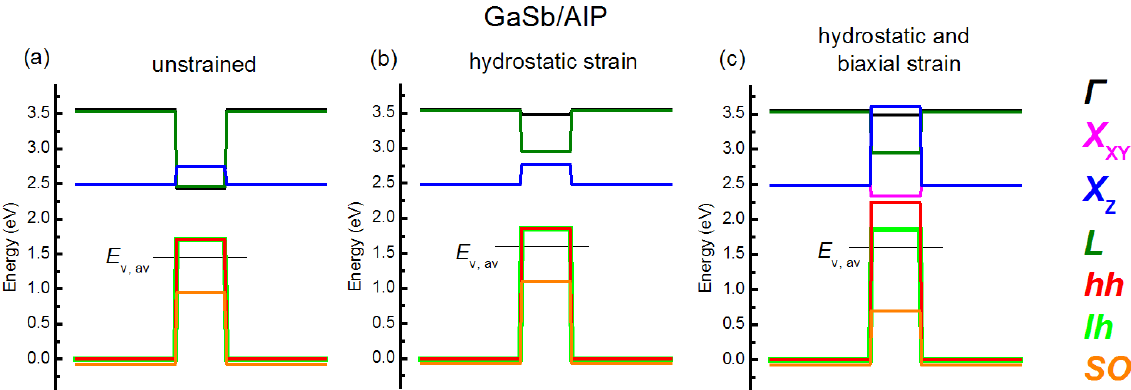
Figure 6. Band alignment for the thin GaSb layer coherently strained to the AlP matrix oriented along the (100) plane. The calculation is performed for 300 K. The band alignment for the unstrained GaSb/AlP layer ( a ), energy shifts due to the hydrostatic strain ( b ) and the both of the hydrostatic and the biaxial strains ( c ) are